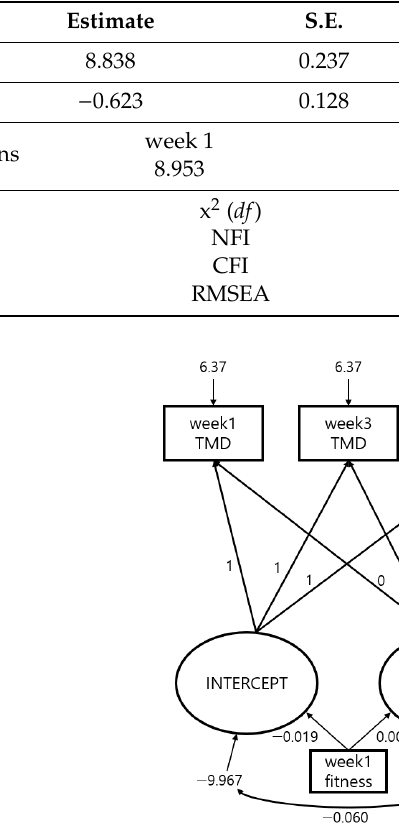
Table 6. Changes in TMD over time per fitness levels.